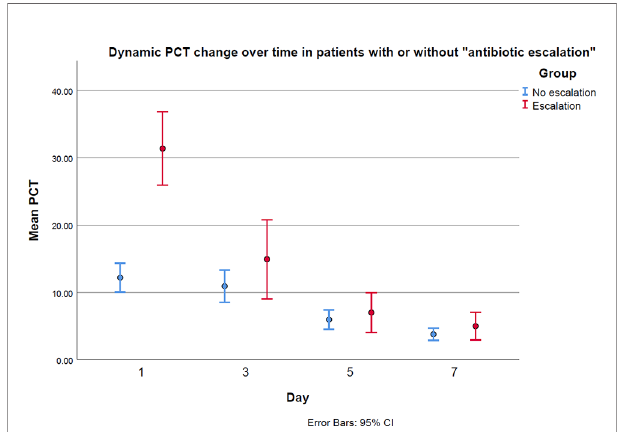
FIGURE 3 | The PCT levels between antibiotic “ escalation ” and “ no escalation ” groups on the fi rst, third, fi fth and seventh days in